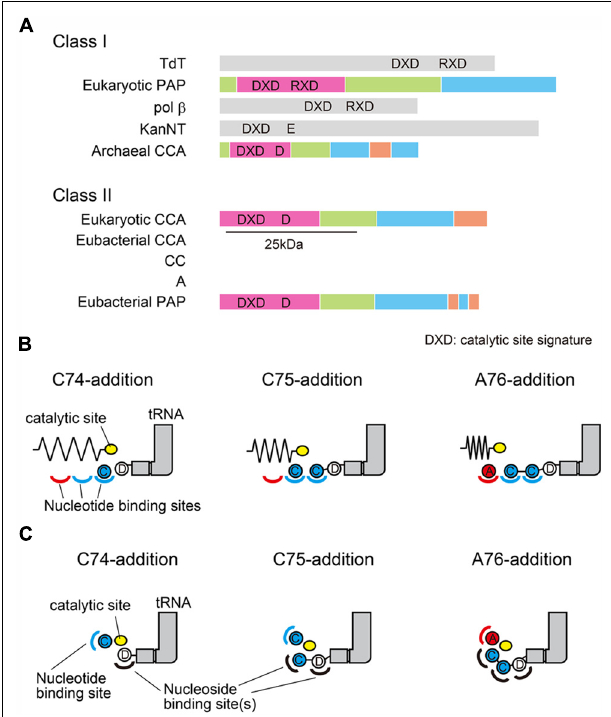
FIGURE 1 |Two classes of CCA-adding enzymes and the proposed models. (A) Schematic representation of two classes of CCA-adding enzymes and their related enzymes. Archaeal CCA-adding enzymes and eukaryotic polyA polymerases (PAP) belong to class-I. Eubacterial/eukaryotic CCA-adding enzymes and eubacterial PAPs belong to class-II.The N-terminal 25 kDa of the class-II CCA-adding enzyme and PAP are homologous. In some eubacteria, CCA-addition is accomplished by two class-II A-adding and CC-adding enzymes. Domains of CCA (or A, or CC)-adding enzymes and polyA polymerases are colored based on the structures as in Figure 2A and Figure 5A . DXD is the active site signature containing two carboxylates.The third catalytic carboxylate is also depicted. (B) Multiple nucleotide binding sites model. CCA is added by using three nucleotide binding sites (two for CTPs and one for ATP) and a mobile single catalytic site. (C) Collaborative templating model.The nucleotide binding site is composed of the refolded 3 (cid:2) -terminus of the RNA and the protein. The nucleotide specificity is collaboratively dictated by the RNA-protein